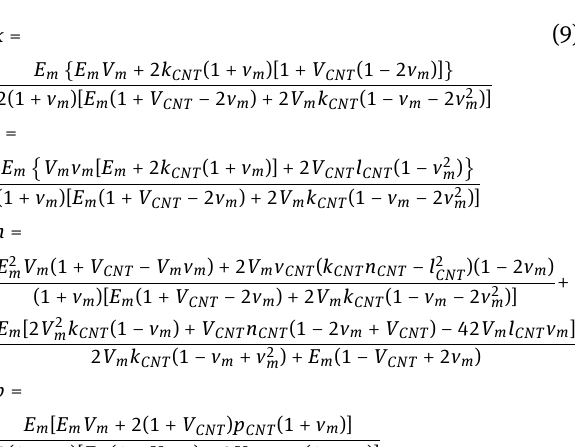
Figure 2: Different configuration of SWCNT-FG layers: a)UD, b) FG-A, c)FG-O, d) FG-X and e)